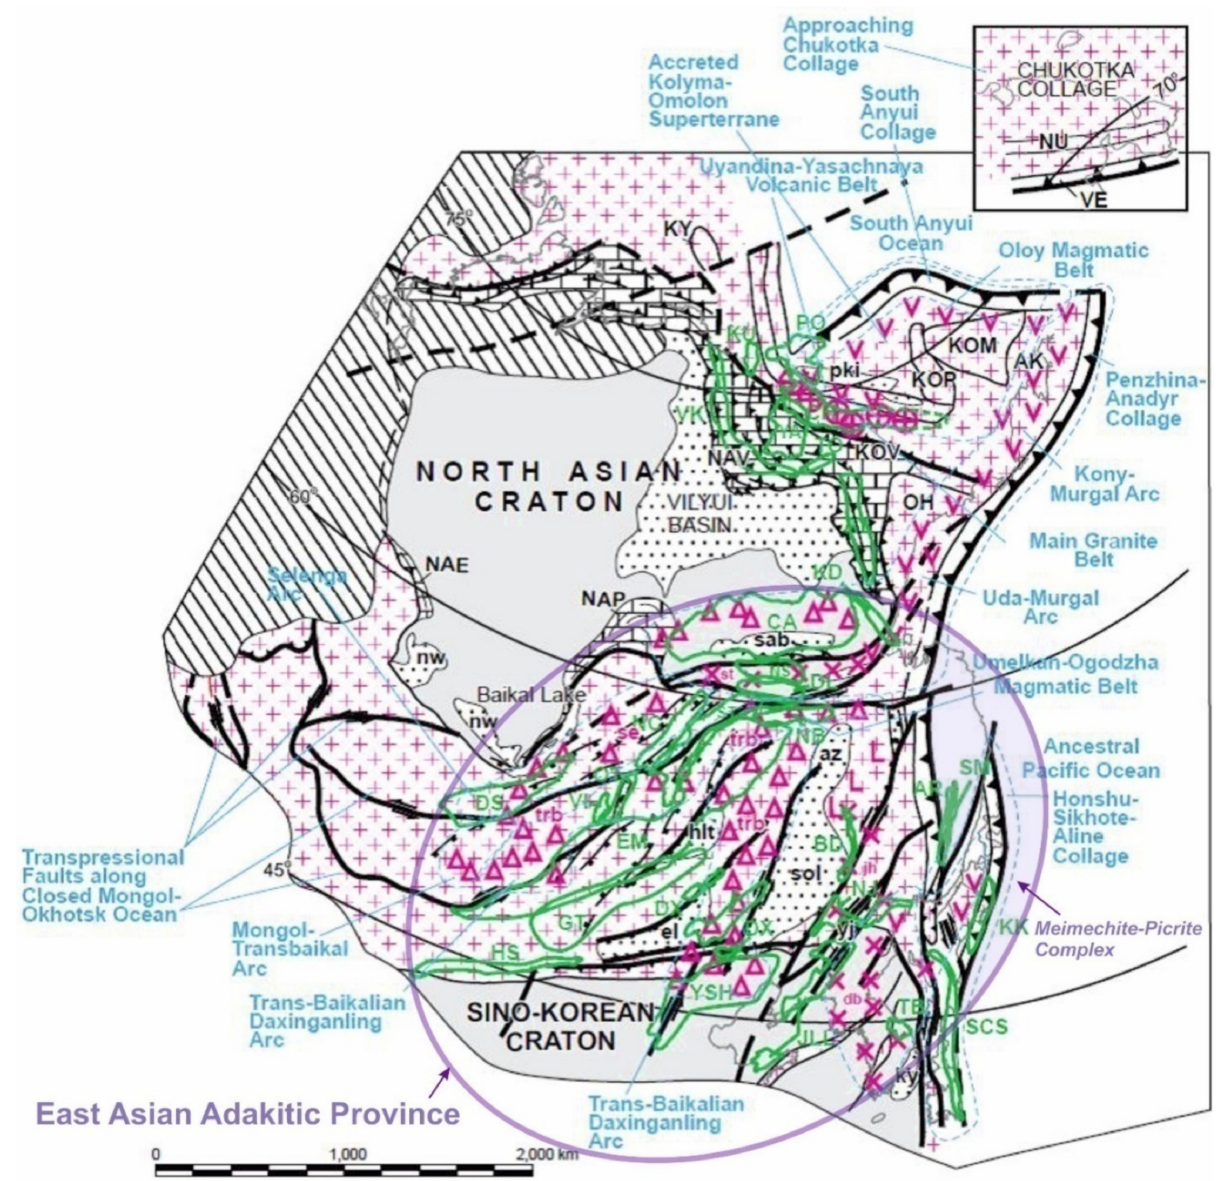
Figure 2. Paleotectonic reconstruction of NE Asia at 145 Ma, showing metallogenic belts of the Middle Jurassic–Early Cretaceous (175–96 Ma) age [4]. East Asian Adakitic Province is shown after [2]. The distribution of meimechite–picrite complex is suggested basing on the studies by [8–11]. North